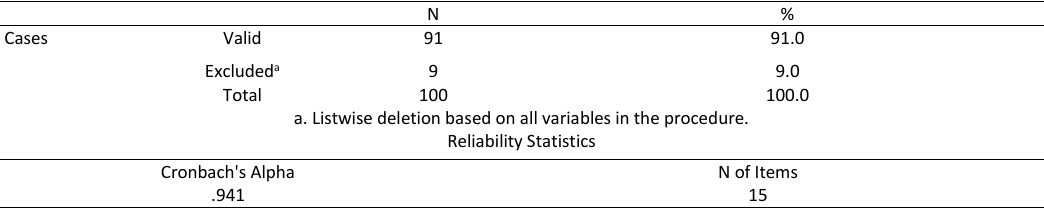
Table 8: Cronback’s alpha test of the measured criteria shows that the reliability of these criteria and sub-criteria is very high N